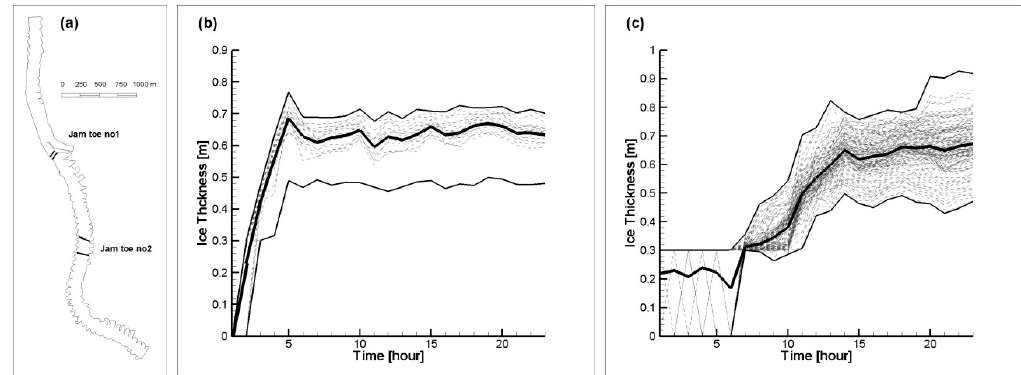
Figure 5. Simulated ice thickness increase over time calculated in the FE nodes: ( a ) sketch showing two locations where an ice jam toe was developed during the simulation; ( b ) ice thickness in the area upstream of the Słubice Bridge; ( c ) ice thickness in the area located about 1300 m upstream of the bridge. The solid thick line represents mean thickness; the dash lines represent ice thickness in model nodes and the solid thin lines are the upper and lower limitations of the ice thickness in selected areas.